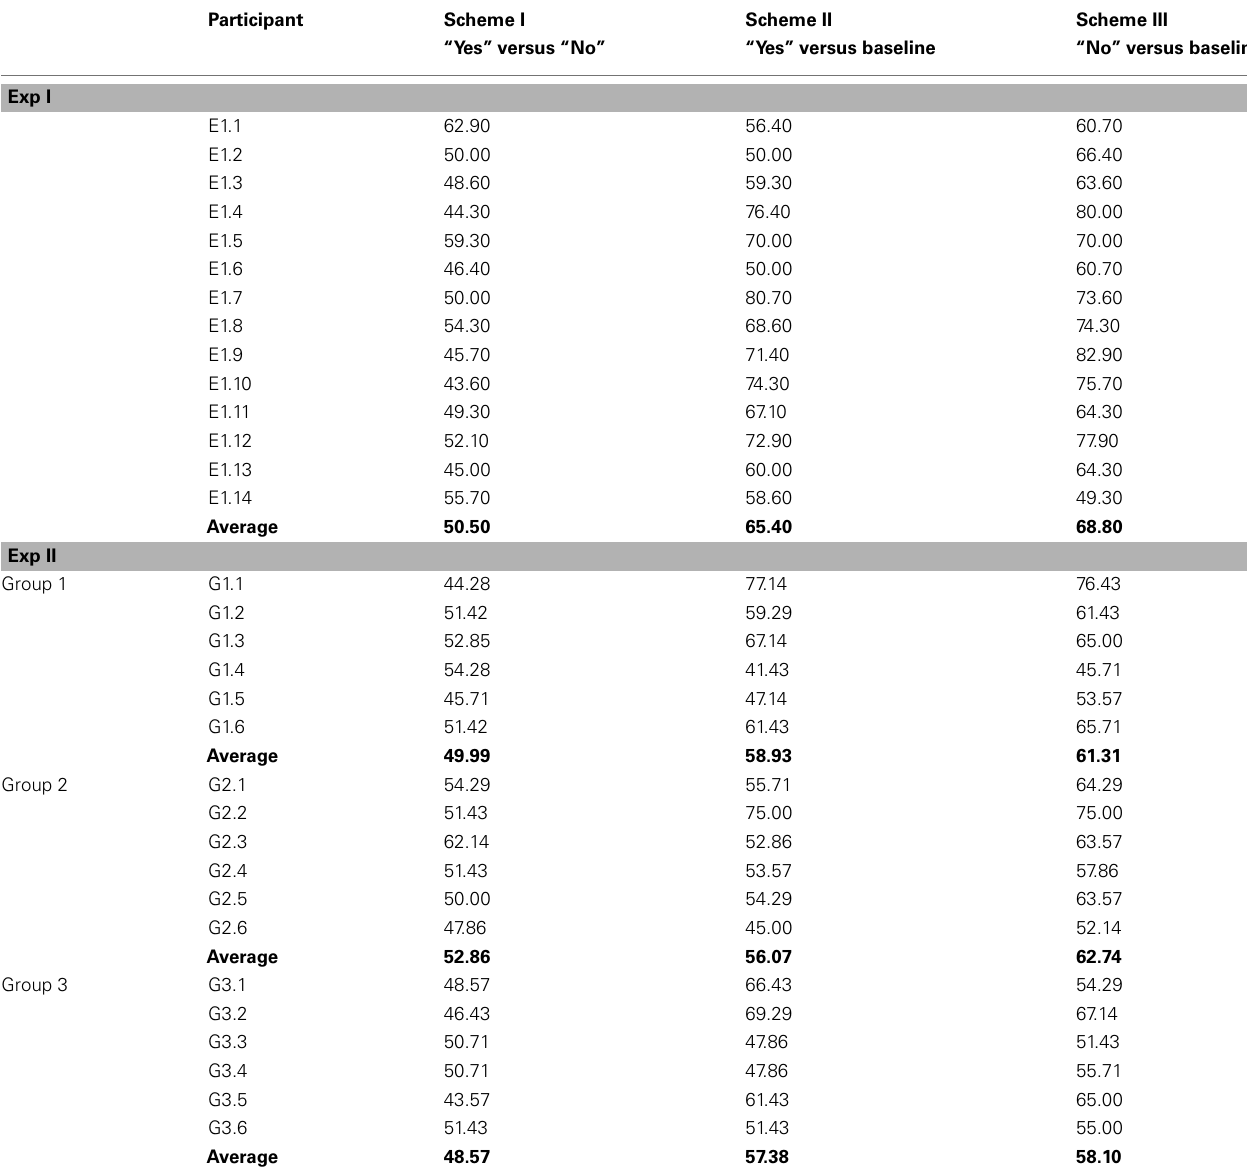
Table 4 | Single-trial classification accuracies achieved with RBF-SVM (in